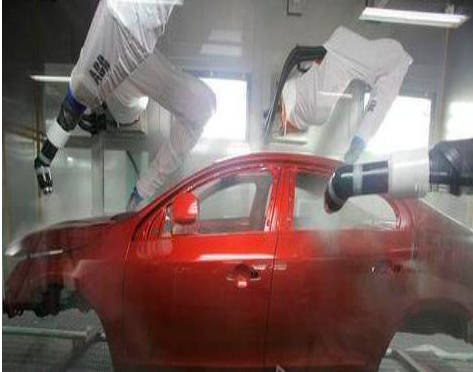
Figure 12. ABB spraying robot.